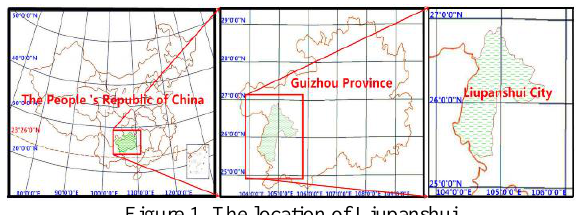
Figure 1. The location of